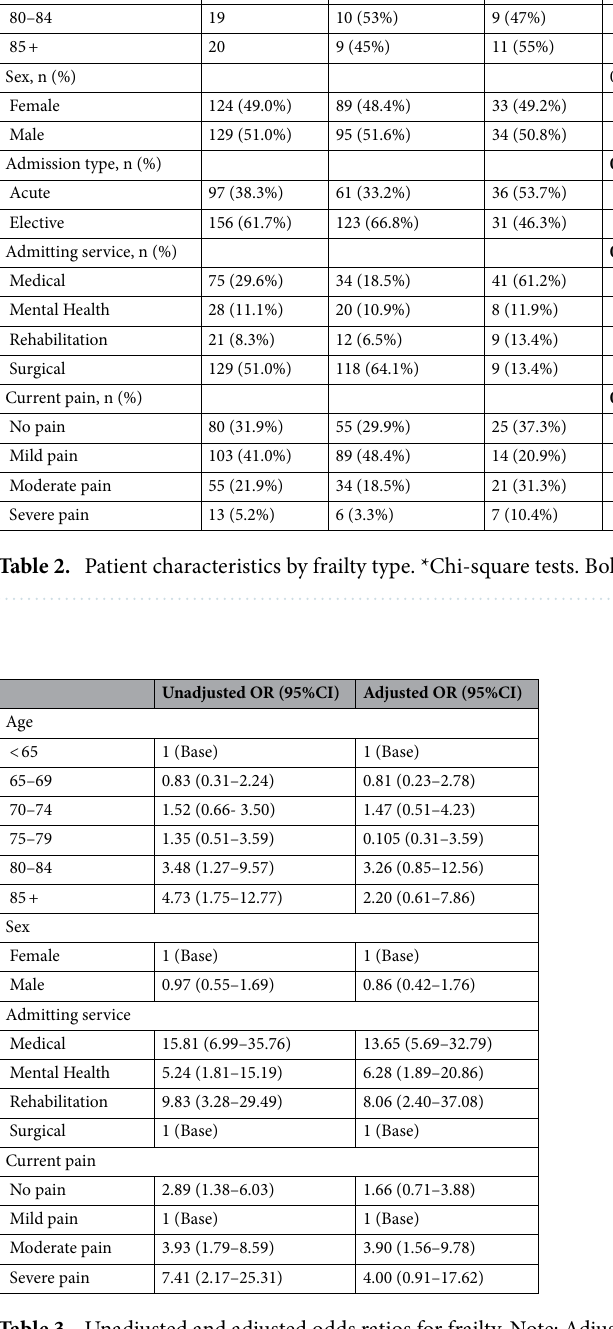
Table 3. Unadjusted and adjusted odds ratios for frailty. Note: Adjusted for age, sex, admitting service and current